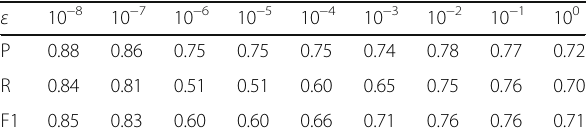
Table 2 The impact of the threshold ε of classification decision function in the VCA method on the classification